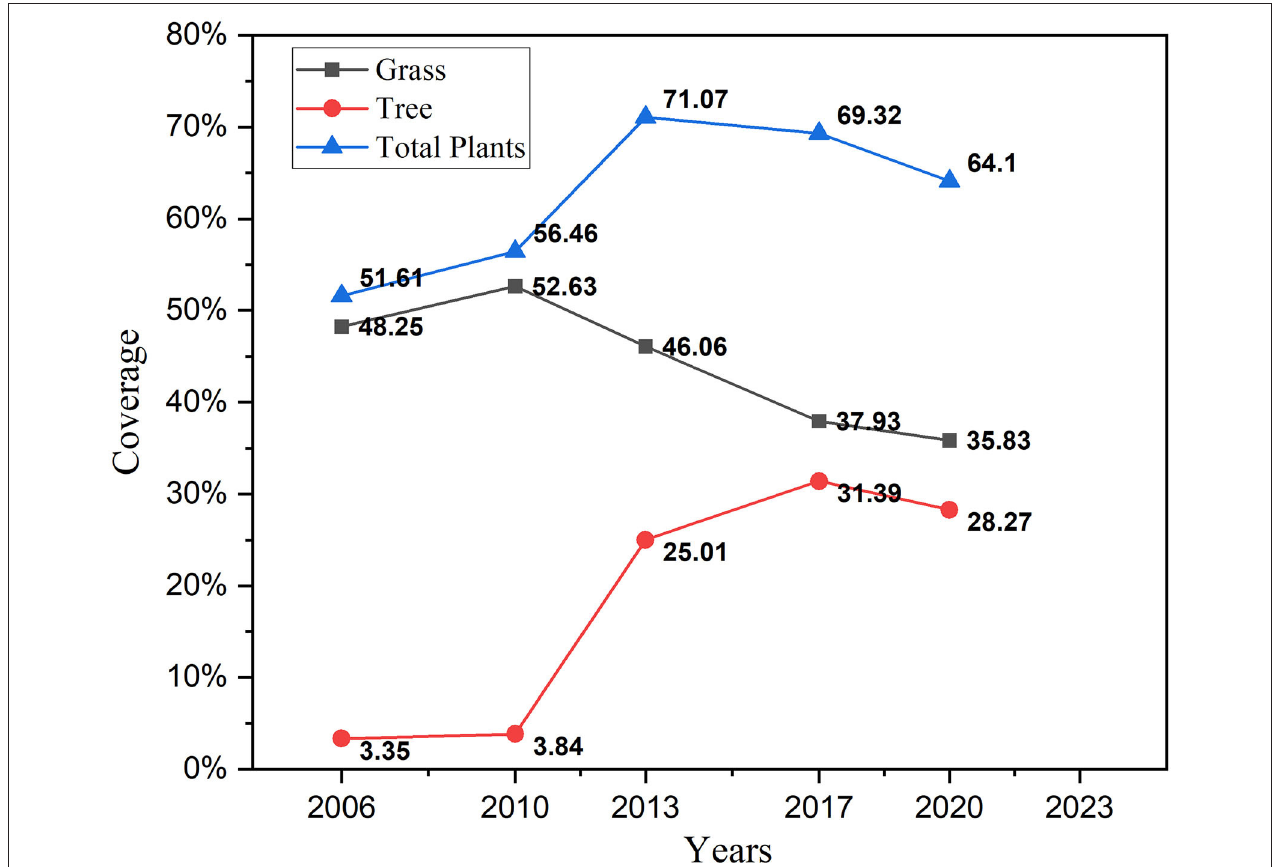
FIGURE 9 | The variation trend of vegetation